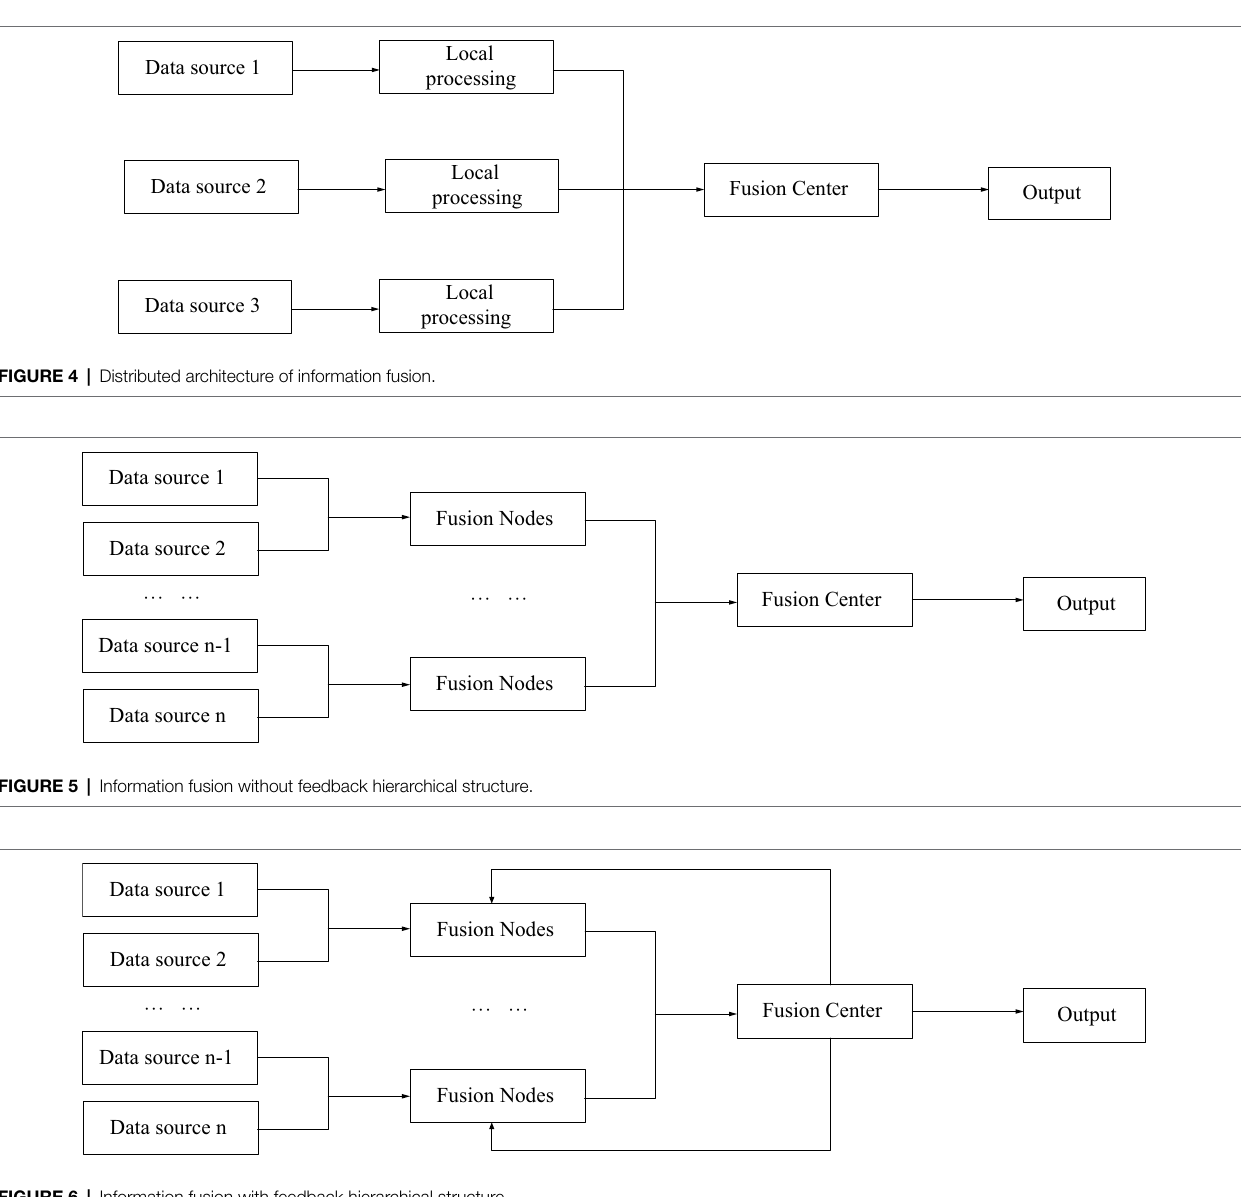
FIGURE 6 | Information fusion with feedback hierarchical structure.